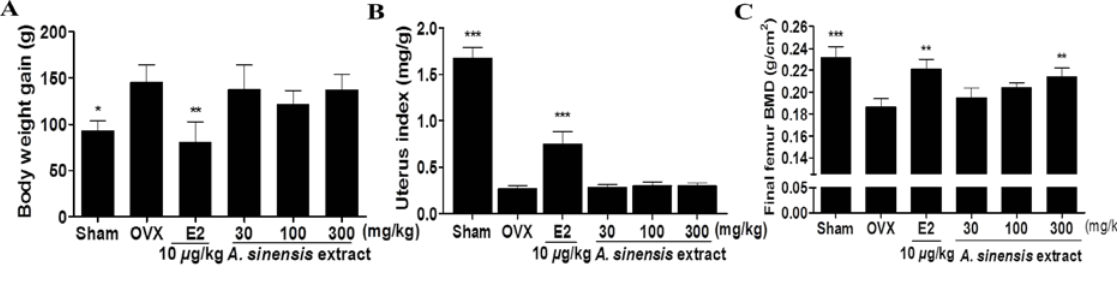
Figure 2. Effects of A. sinensis extract on body weight gain ( A ); uterus index ( B ); and bone mineral density (BMD) ( C ) in ovariectomized (OVX) rats. The body weight gain